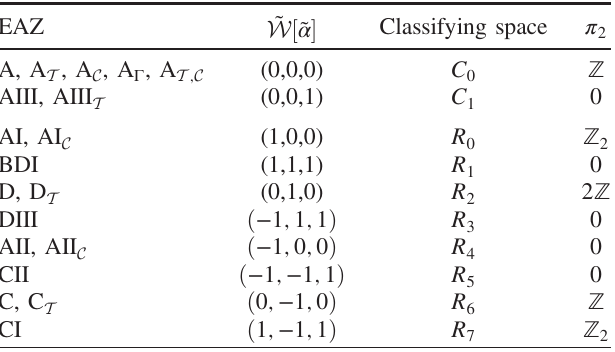
TABLE III. Classification of EAZ symmetry classes. The subscripts T , C , and Γ signify that irreducible representations are related by the on-site antiunitary and the chiral symmetries.